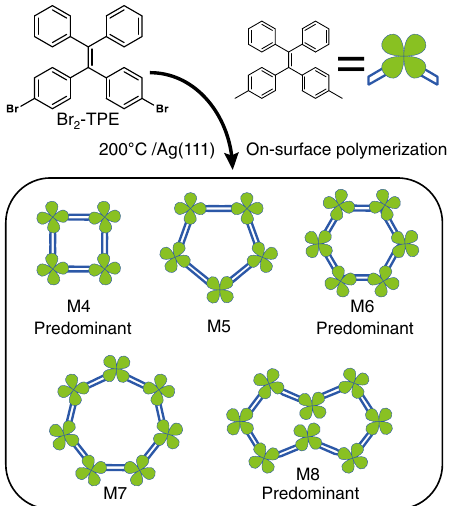
Fig. 1 On-surface synthesis of tetraphenylethylene macrocycles. Oligo- tetraphenylethylene macrocycles formed via the on-surface Ullmann coupling reaction of 4,4 ′ -(2,2-diphenylethene-1,1-diyl)bis(bromobenzene) (Br 2 -TPE)